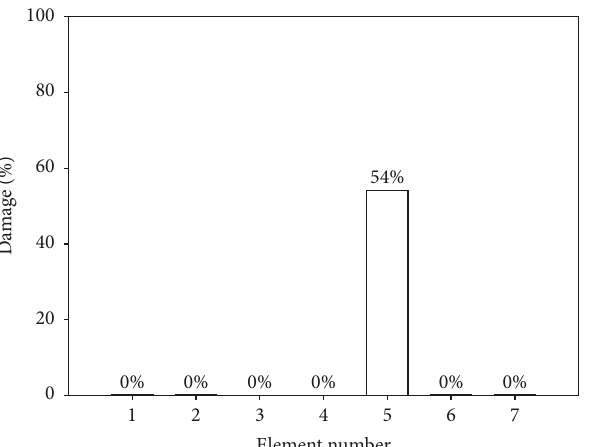
Figure 12: Predicted damage for the spring-mass system when evaluating model 1. Expected damage level of 55% at the fifth element.